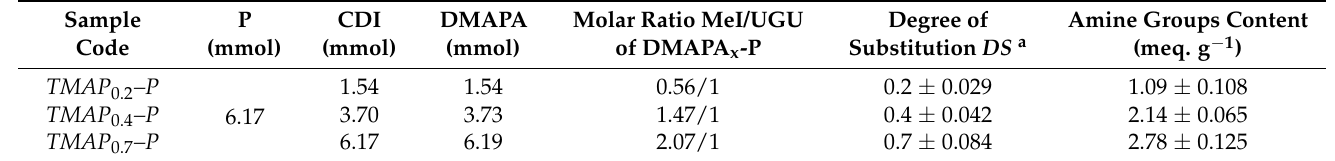
Table 3. Synthesis parameters and structural characteristics of synthesized pullulan